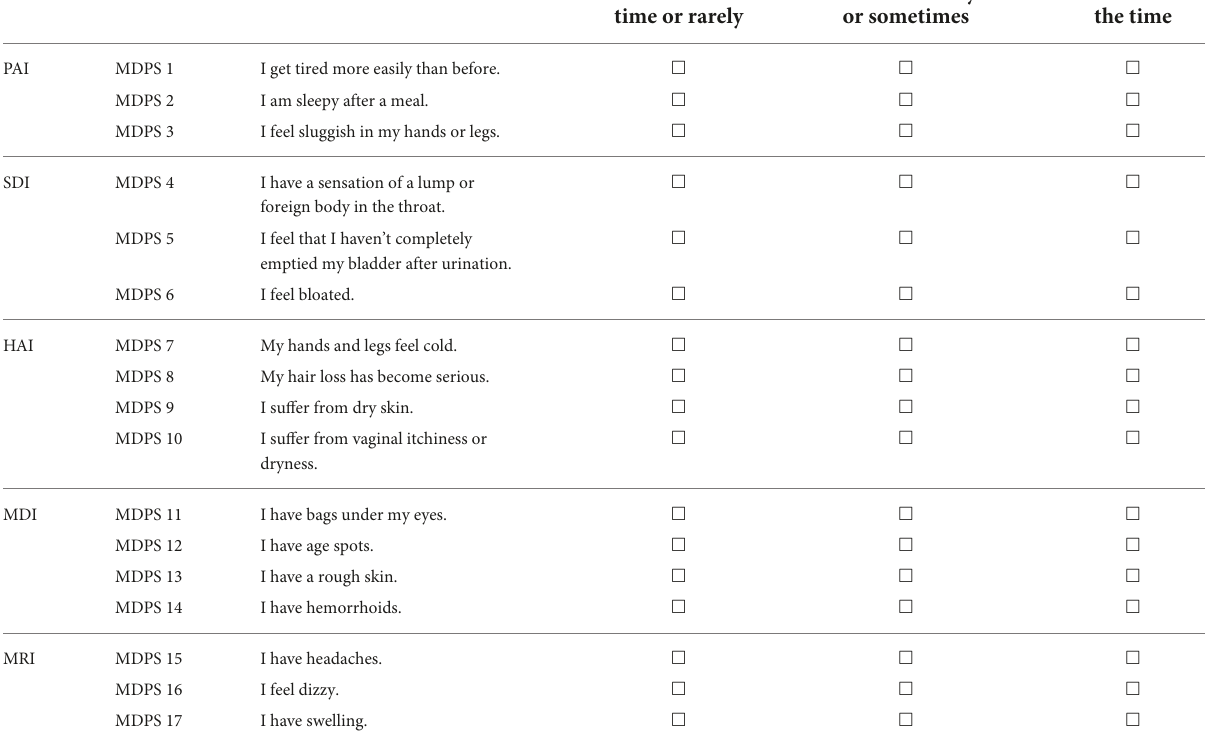
TABLE 1 Candidate questions for MDPS